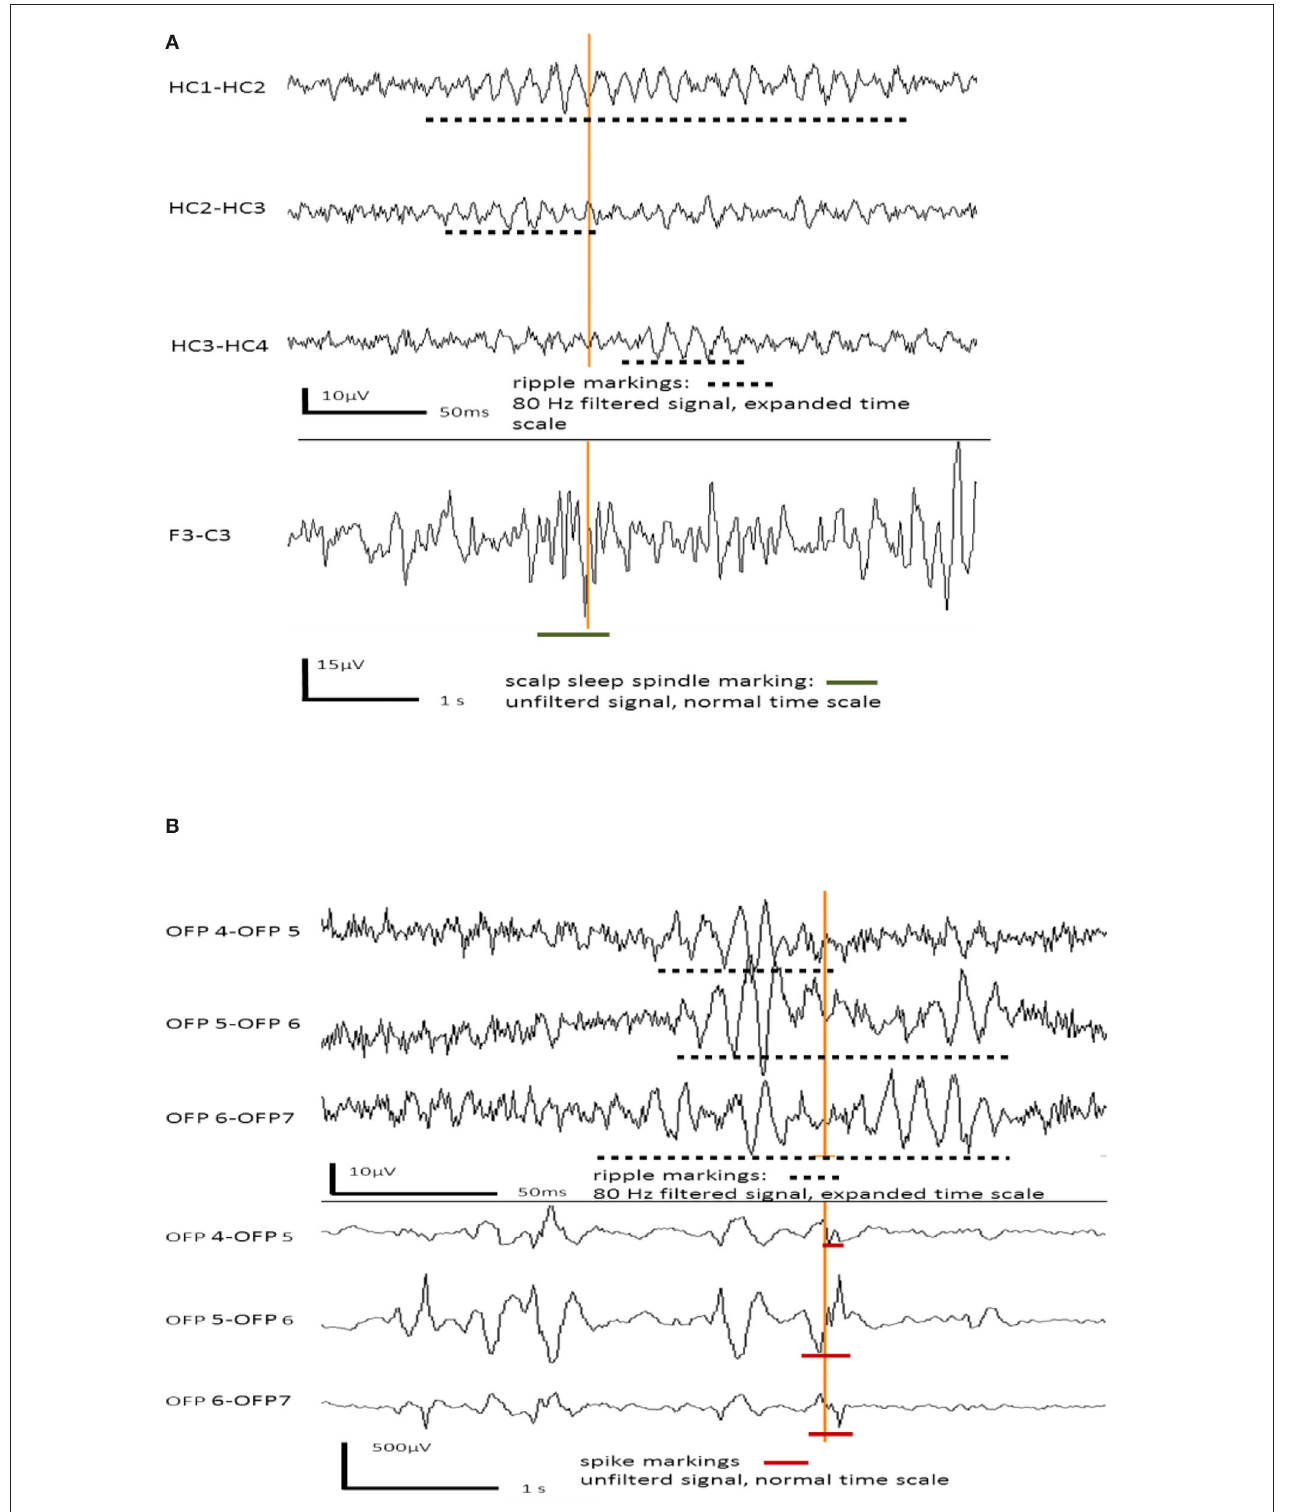
FIGURE 1 | (A) Example for hippocampal ripples in intracranial EEG channels co-occurring with a frontal sleep spindle in scalp EEG. (B) Example for hippocampal ripples co-occurring with interictal epileptic spikes in the same intracranial EEG channels.